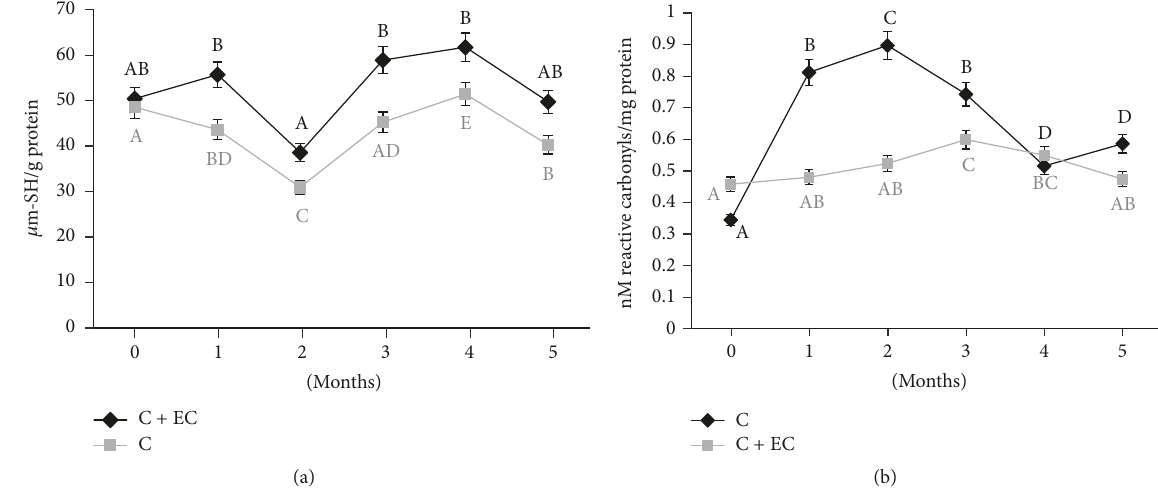
Figure 3: Changes in sulfhydryl content (a) and protein carbonyl content (b) values of common carp fillets stored at − 18 ∘ C for 5 months. The results are the mean of three replications. C: fillet carp without coating; C + EC: fillet carp with edible coating. The different letters indicate significant differences between treatment times for the same treatment ( 𝑝 < 0.05